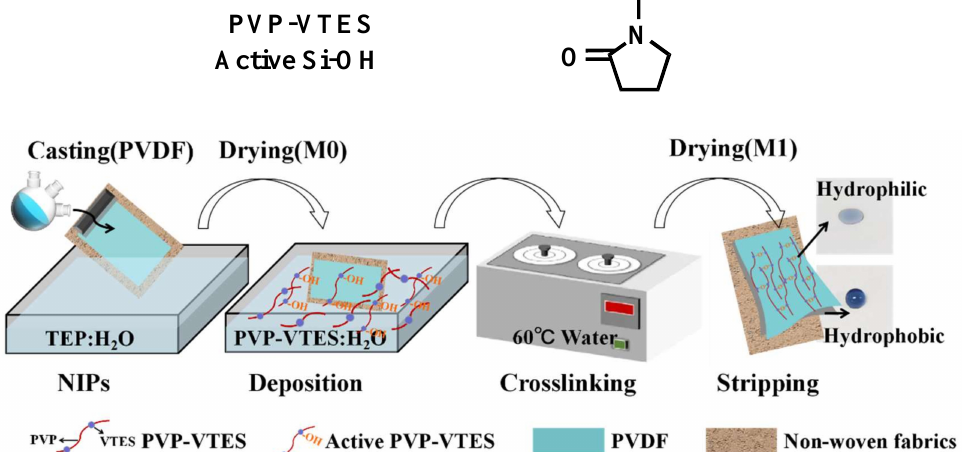
Figure 1. Schematic of the preparation of M0 and M1.